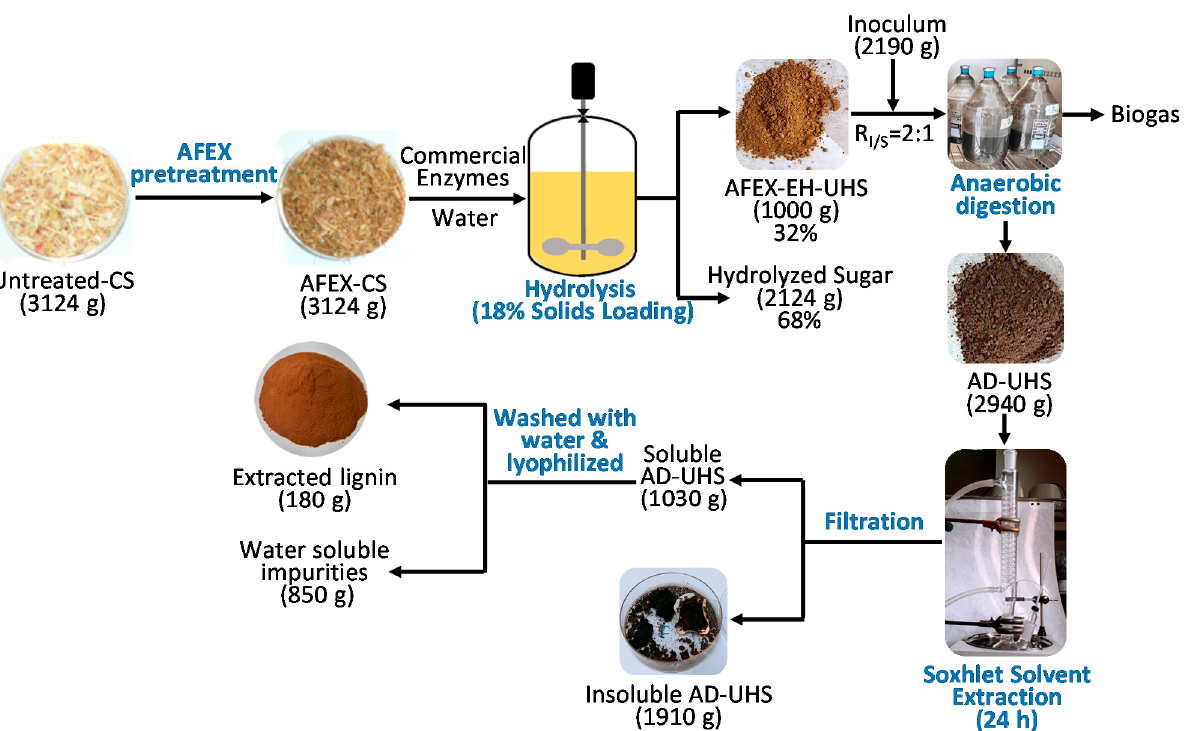
Figure 1. Schematic diagram of the process showing the extraction of lignin from AD-UHS using AcOH solvent.